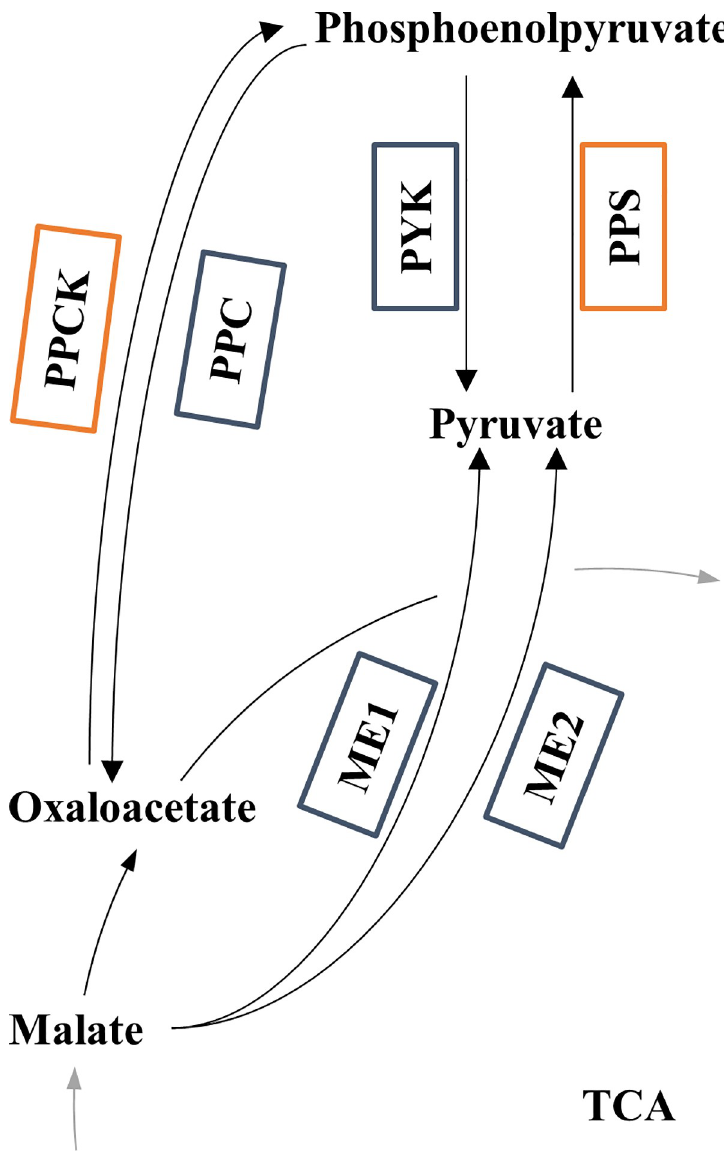
Fig 2. Anaplerotic node for E. coli . Set of carboxylation/decarboxylation reactions including phosphoenolpyruvate, pyruvate, oxaloacetate, and malate. Arrows indicate the expected direction of carbon fluxes. Boxes refer to reactions: blue when they are defined in both the GSM and the metabolic network used for 13 C-MFA, and orange when they are exclusively considered in the GSM. In the latter case no mapping was possible (S1